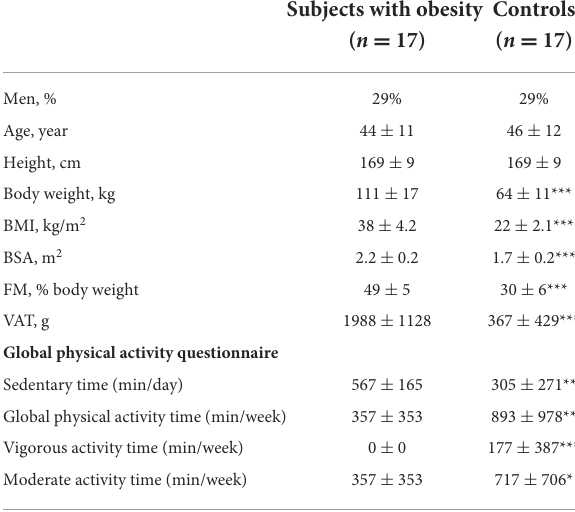
TABLE 1 Baseline characteristics of subjects with obesity and controls. Subjects with obesity